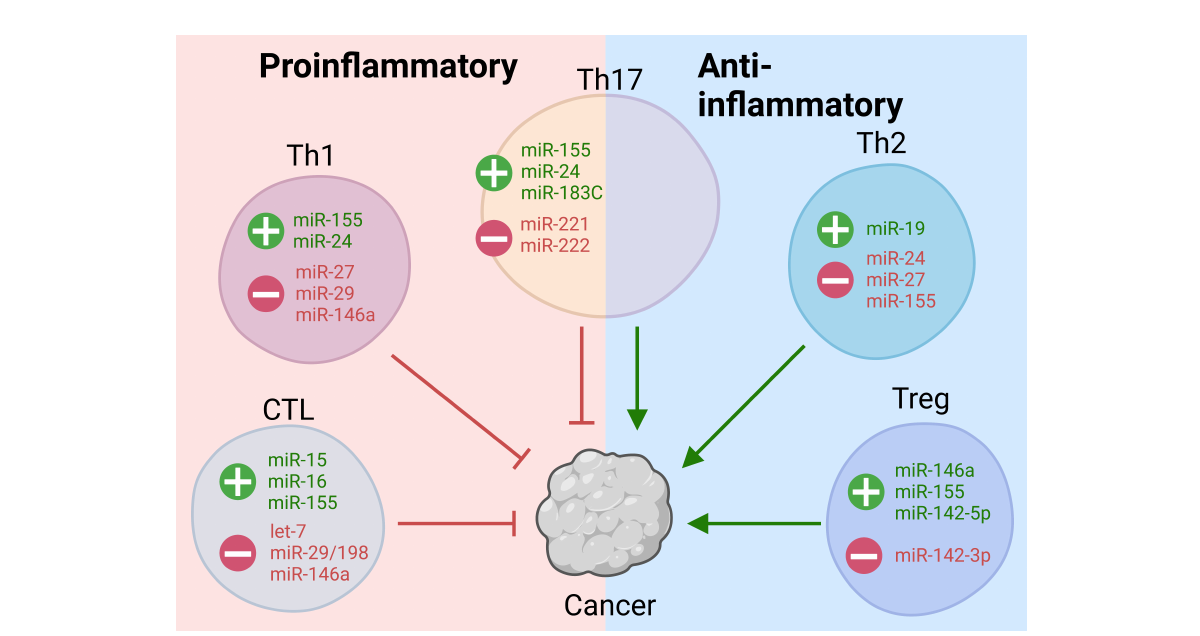
FIGURE 1 T-cell miRNAs regulate the function of CTLs and helper T-cell subsets in the TME. T-cell miRNAs regulate proin fl ammatory anti-tumorigenic and anti-in fl ammatory protumorigenic T cells in the TME. Several miRNAs regulate the fate and function of multiple T-cell subtypes, all of which play de fi ned roles in cancer progression and elimination. These miRNAs and respective targets give mechanistic insights into potential therapeutic targets and